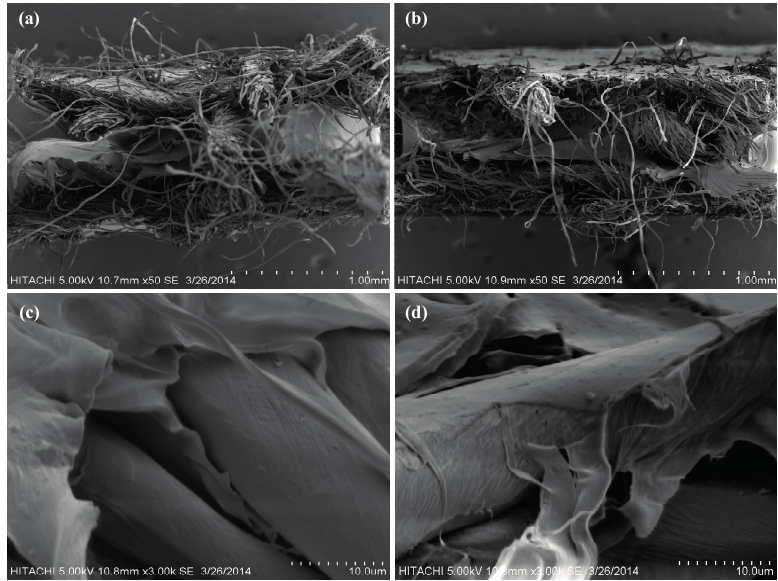
Figure 4. SEM micrographs of the fractured surfaces of the ( a ) LDPE/untreated CW biocomposite; ( b ) LDPE/treated CW biocomposite (at magnification of 50×); ( c ) LDPE/untreated CW biocomposite; and ( d ) LDPE/treated CW biocomposite (at magnification of